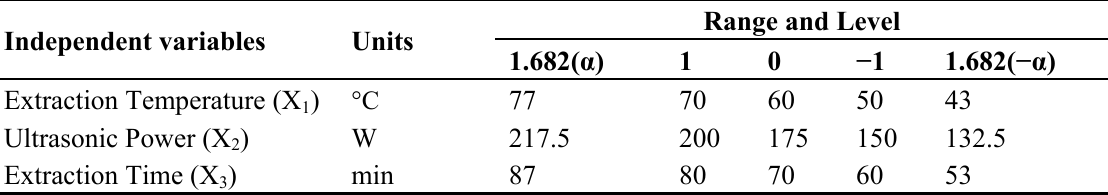
Table 5. Levels of variables for the experimental